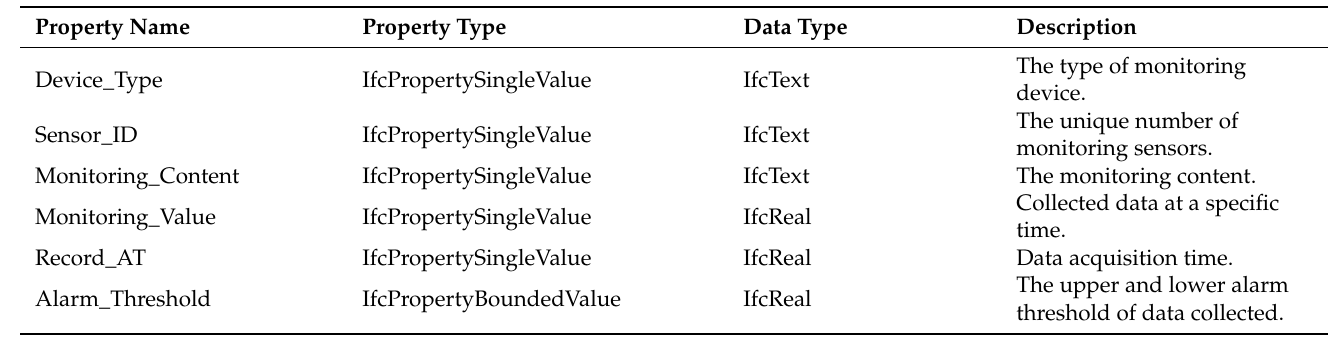
Table 2. Pset_SensorFeature Property Definition.